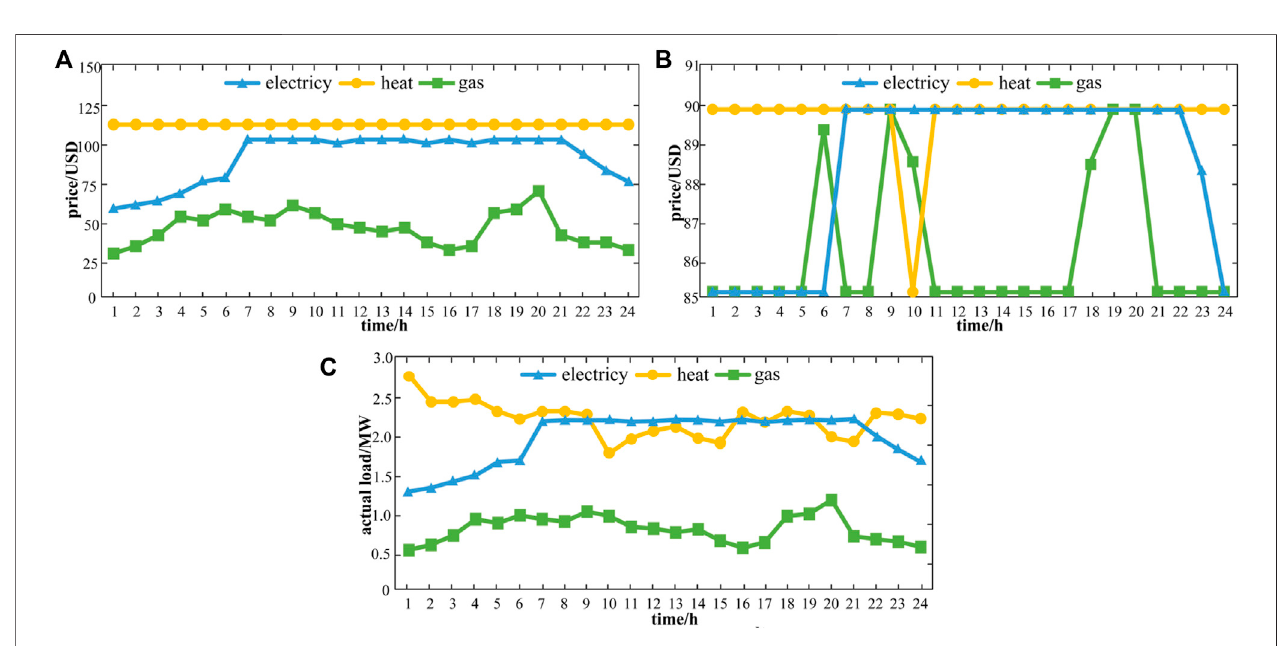
FIGURE 9 | Multi-agent